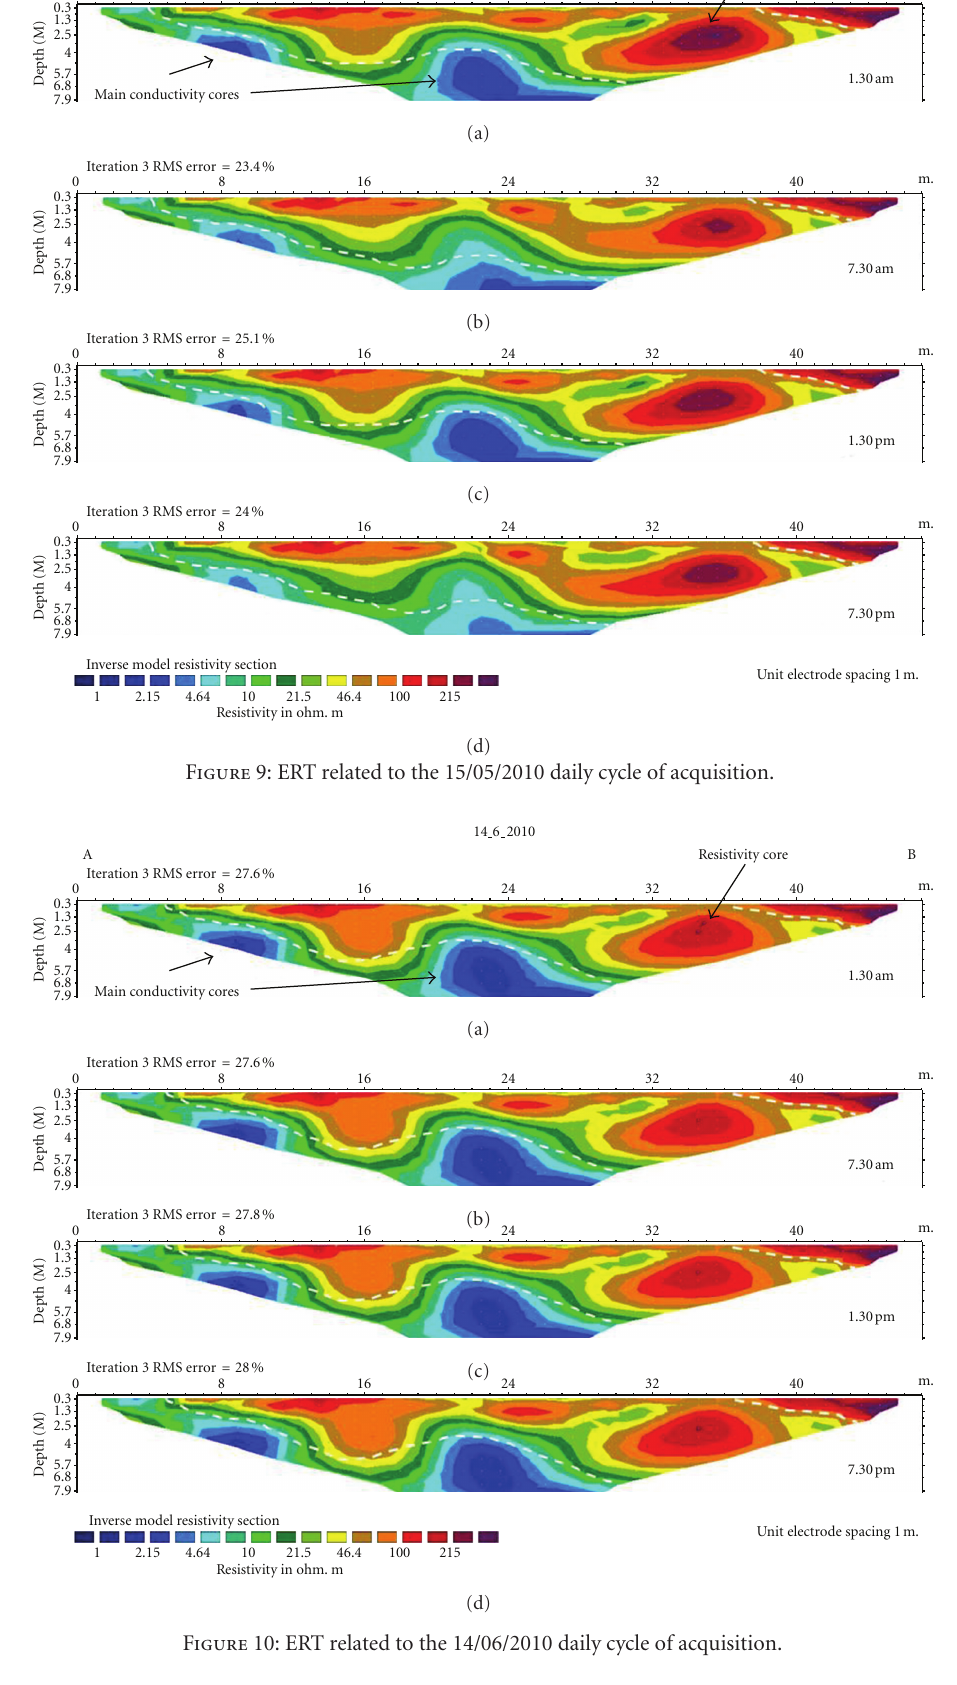
Figure 10: ERT related to the 14/06/2010 daily cycle of